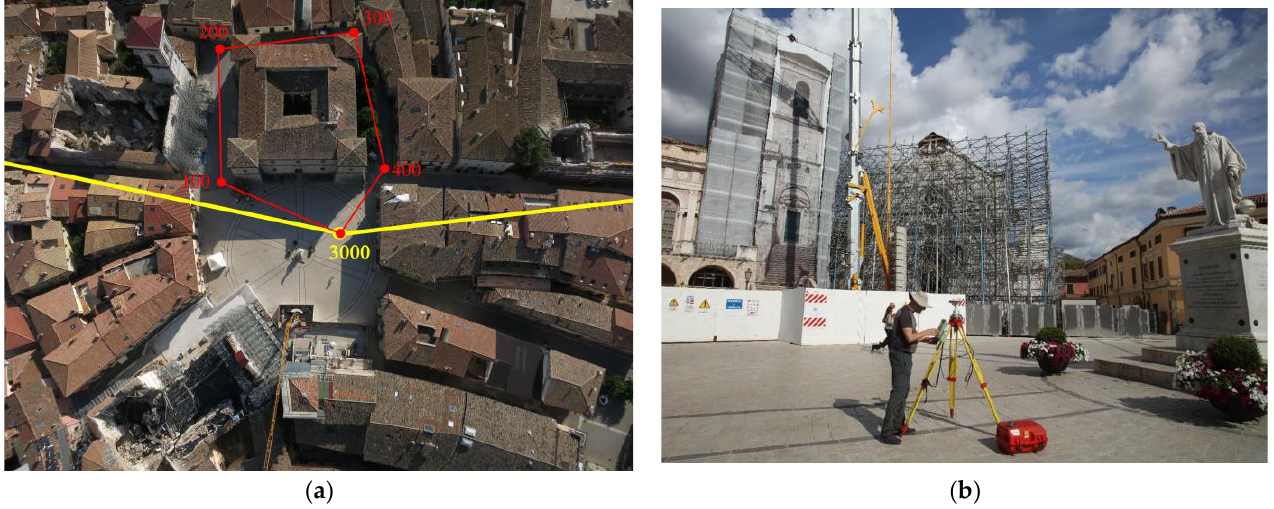
Figure 2. ( a ) Nadir view of Norcia square with an excerpt of 1st and the 2nd order control network and ( b ) the San Benedetto basilica ruins, during the acquisition phases.